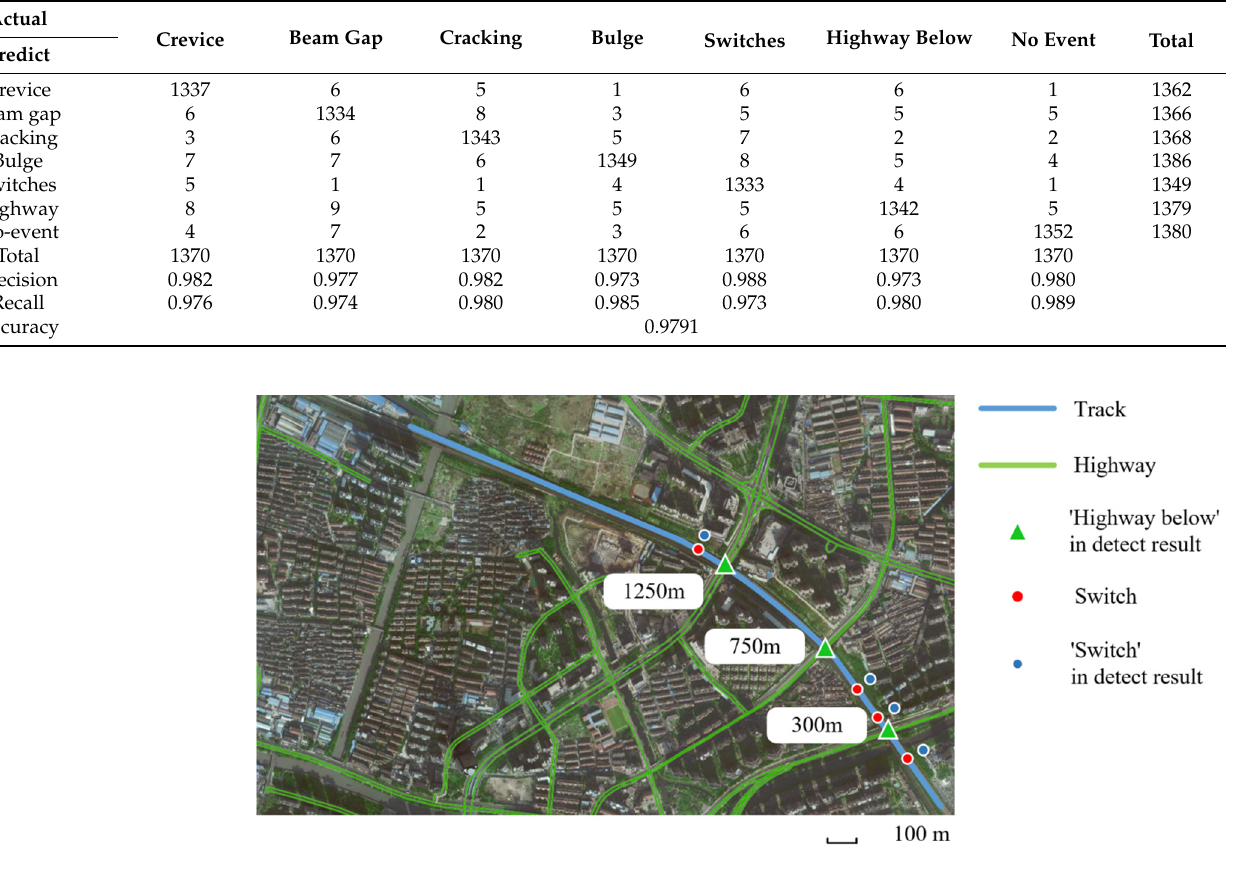
Figure 13. Visualization for detection on actual data. Table 9. Confusion matrix for classification of ‘defect’ and ‘no-defects’.